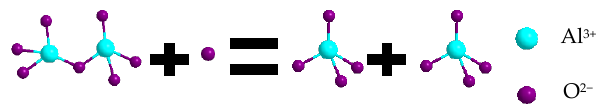
Figure 18. Schematic diagram of Na 2 O deploymerize the [AlO 4 ] 5 − -tetrahedral structure.